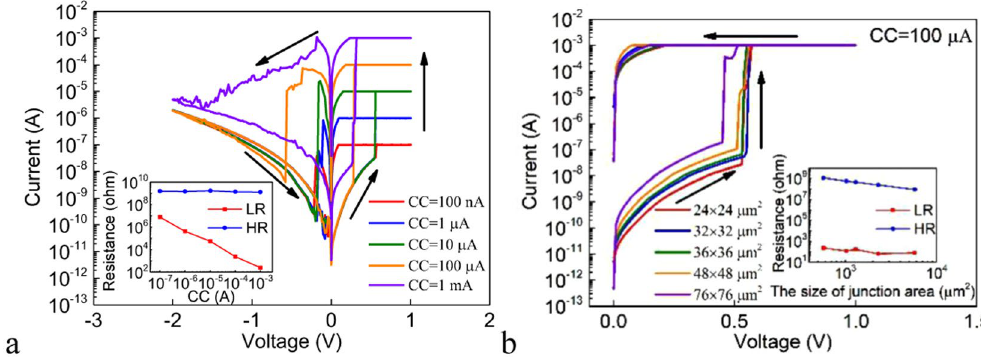
Figure 6. ( a ) The DC I-V curves under the different SET CCs for the Ag/GeS/Pt cell. Inset: the dependence of the LR and HR on the CC for the Ag/GeS/Pt cell. ( b ) The DC I-V curves in the SET process for Ag/GeS/Pt devices with different sizes of the junction areas under the SET CC of 100 μ A. Inset: the dependence of the LR and HR on the size of the junction area for the Ag/GeS/Pt